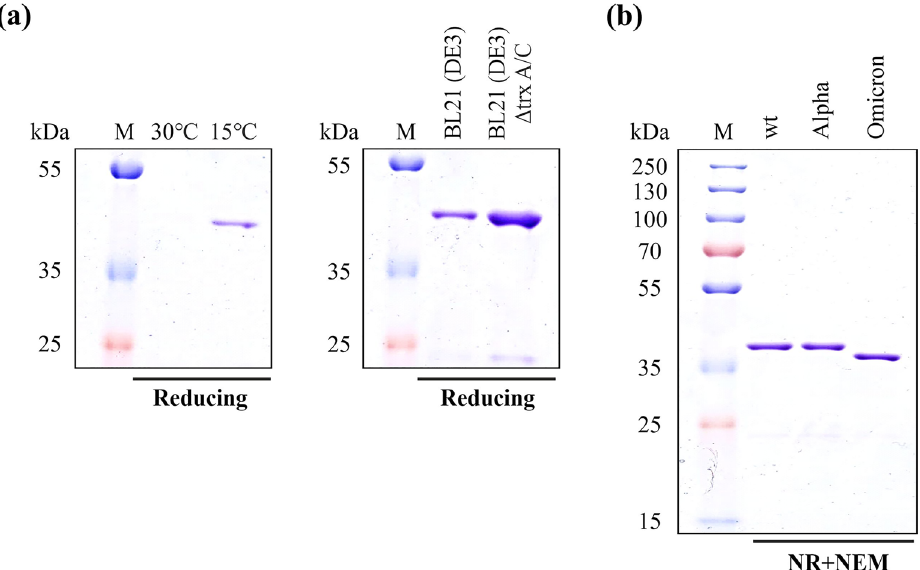
Figure 2. ( a ) SDS-PAGE analysis of IMAC purified mtDsbC-SARS-CoV-2 RBD wild type (wt) fusion protein under reducing conditions at two different post-induction temperatures in E. coli BL21 (DE3) and comparison of soluble protein obtained in two different E. coli strains at 15 °C. ( b ) SDS-PAGE analysis of purified mtDsbC- SARS-CoV-2 RBD fusion protein under non-reducing (NR), NEM treated conditions; (M: Protein Marker). The protein of interest was purified using a combination of IMAC, ion exchange and size-exclusion chromatography. See Supplementary Fig. S3 for the uncropped gel